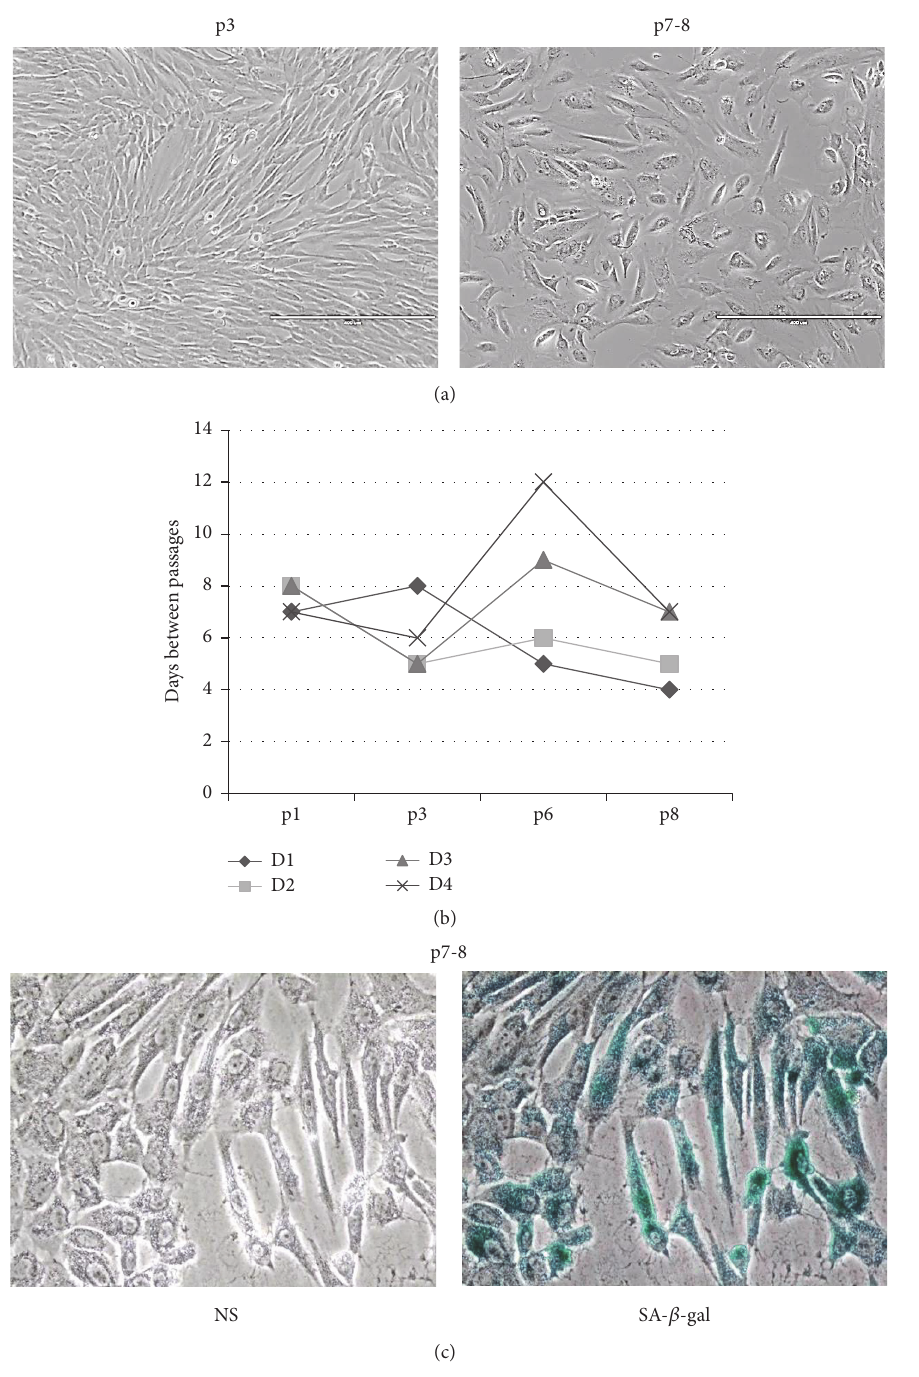
Figure 1: Characteristics of MSCs derived from AF of normal and pathological gestation during cultivation. (a) Representative images of initially spindle-shaped MSCs morphology in early (p3) and senescent passages (p7-8) with a 40x magnification are presented. (b) Differential proliferation of MSCs from AF of individual donors (D) during cultivation to passage 8. (c) Senescence-associated 𝛽 -galactosidase staining in the late passage (p7-8); NS: nonstained cells. Representative results of four independent MSC preparations are